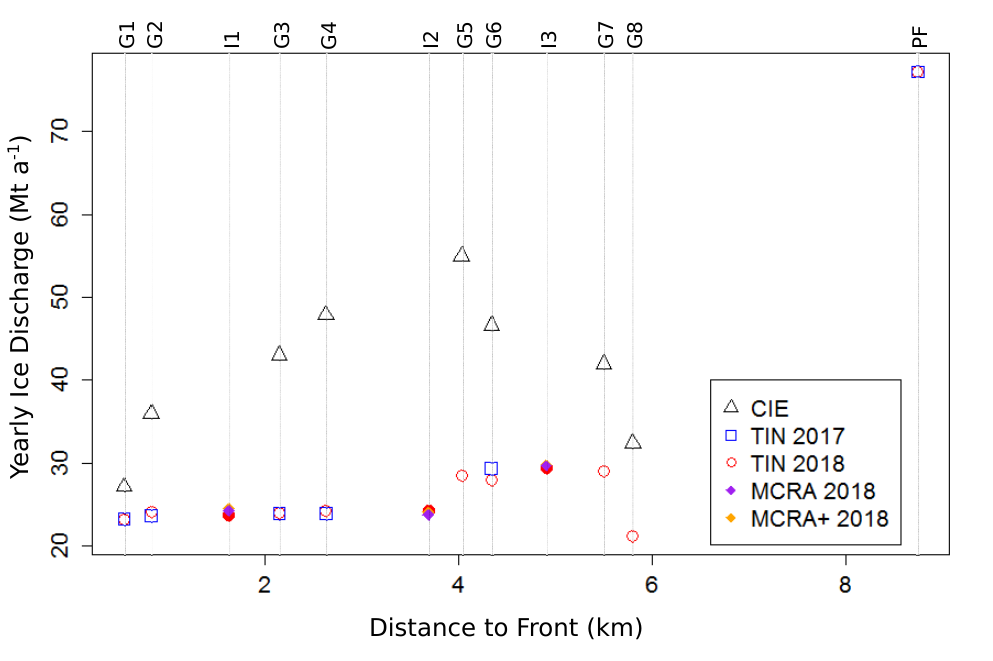
Figure 10. Ice discharge (Mta − 1 ) in the year 2017 for the different ice thickness sources from in situ (unfilled symbols) and interpolated (filled symbols) data along the flux gates shown in Figure